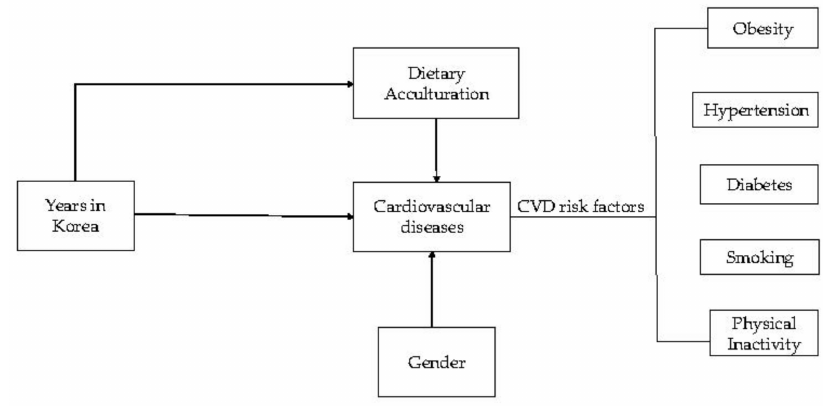
Figure 1. Preliminary conceptual model of the relationship between duration of residence in Korea, dietary acculturation, and cardiovascular disease (CVD) risk